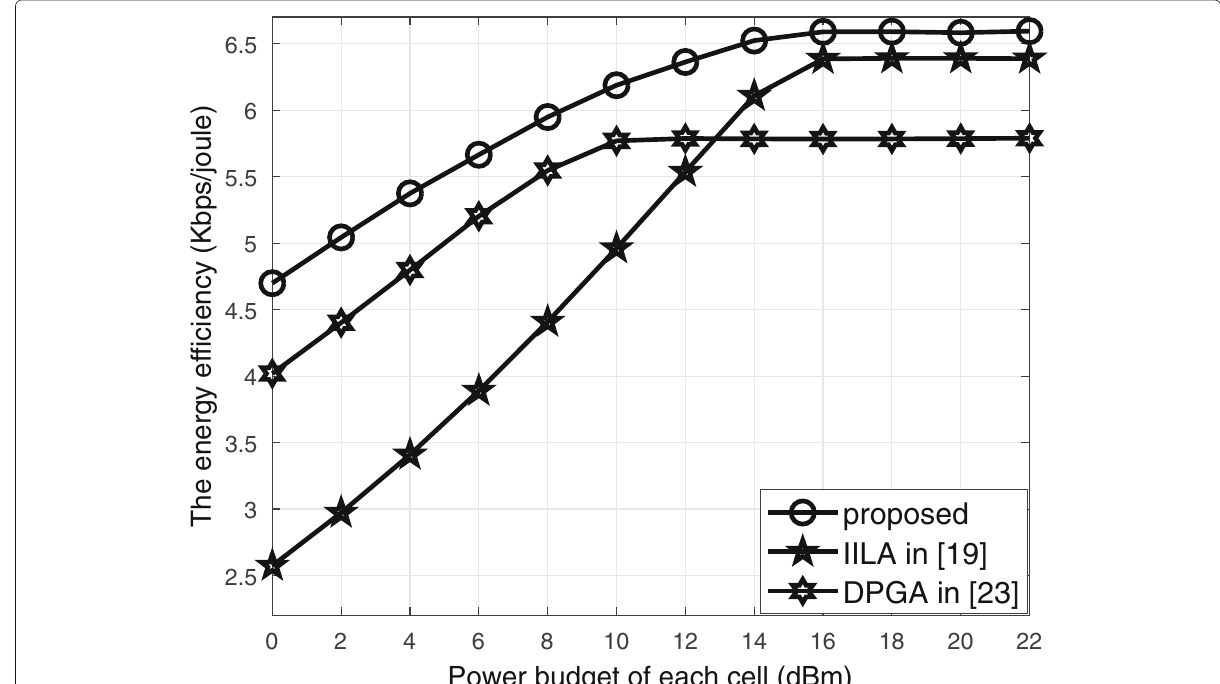
Fig. 5 Comparison of algorithms. The performance comparison of the proposed algorithm with some existing ones versus different sum power